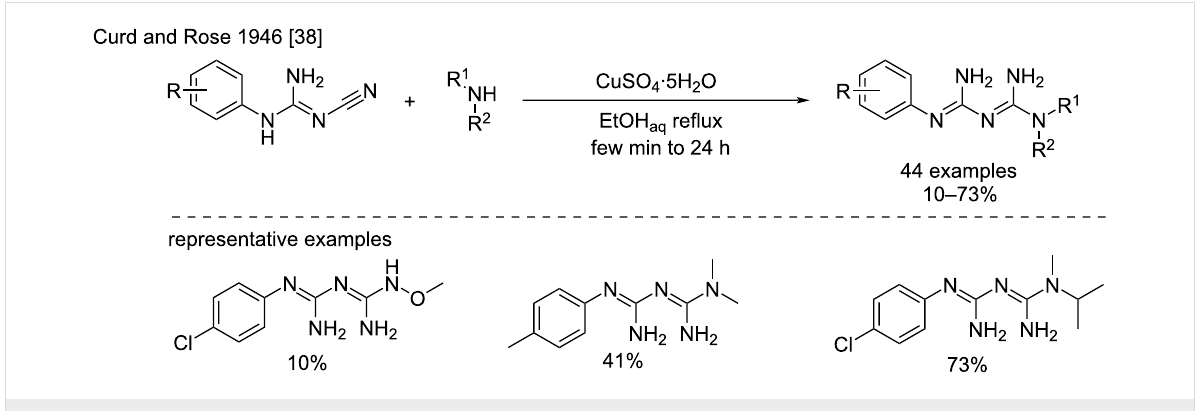
Scheme 14: Synthesis of disubstituted biguanides with Cu(II) salts [38].